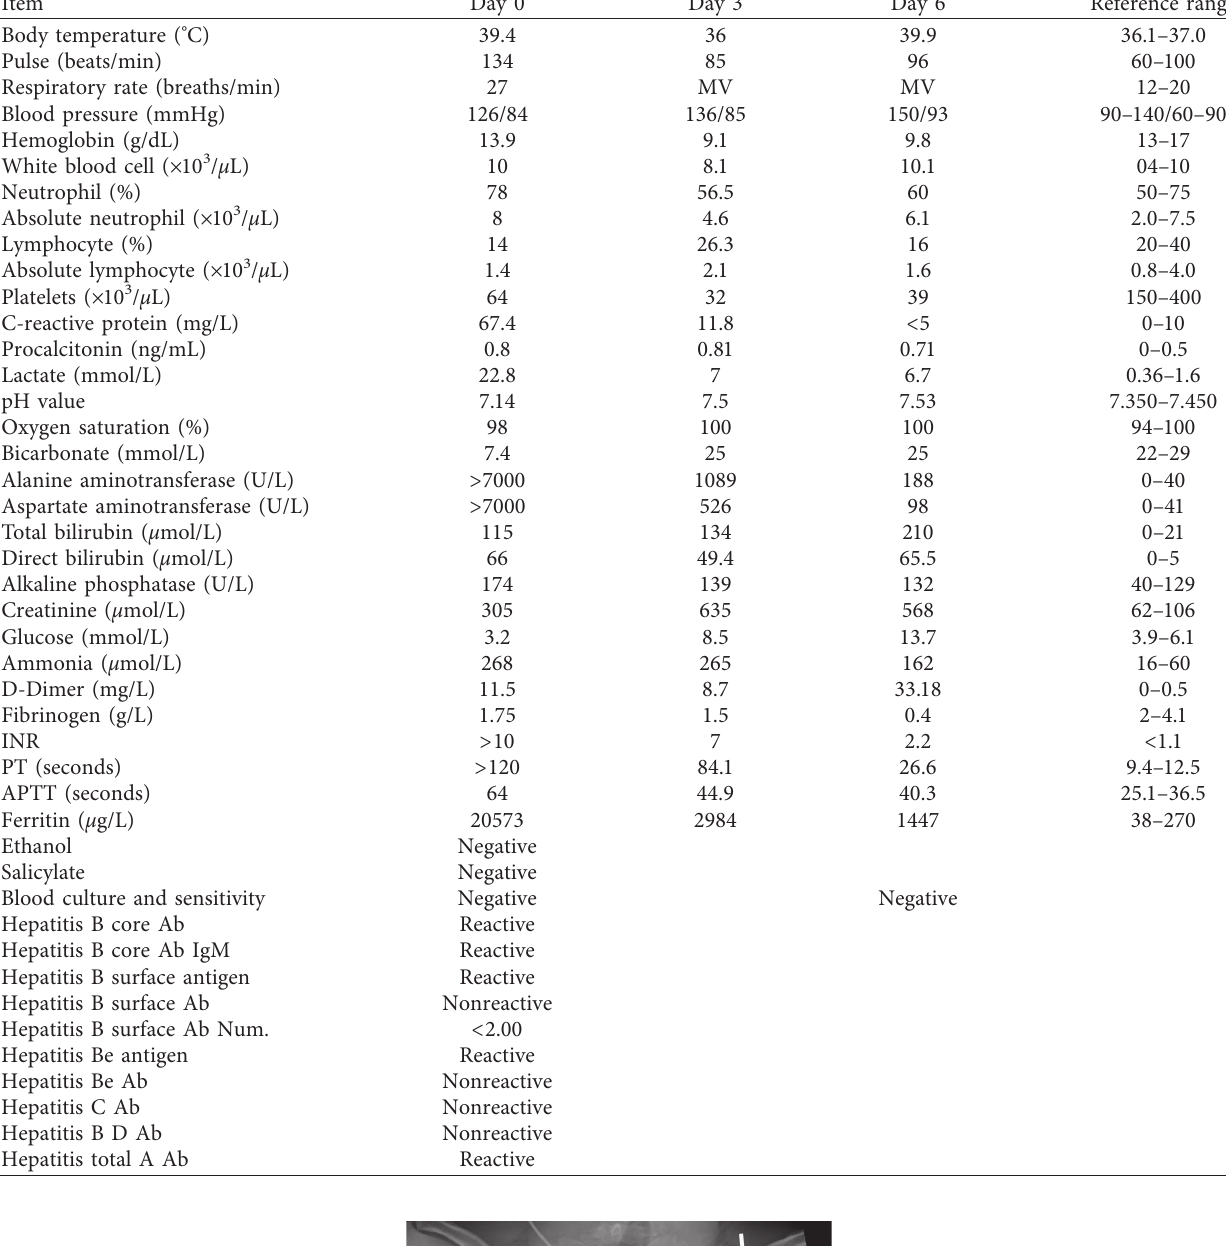
Table 1: Clinical laboratory results on days 0, 3, and 6 of treatment.